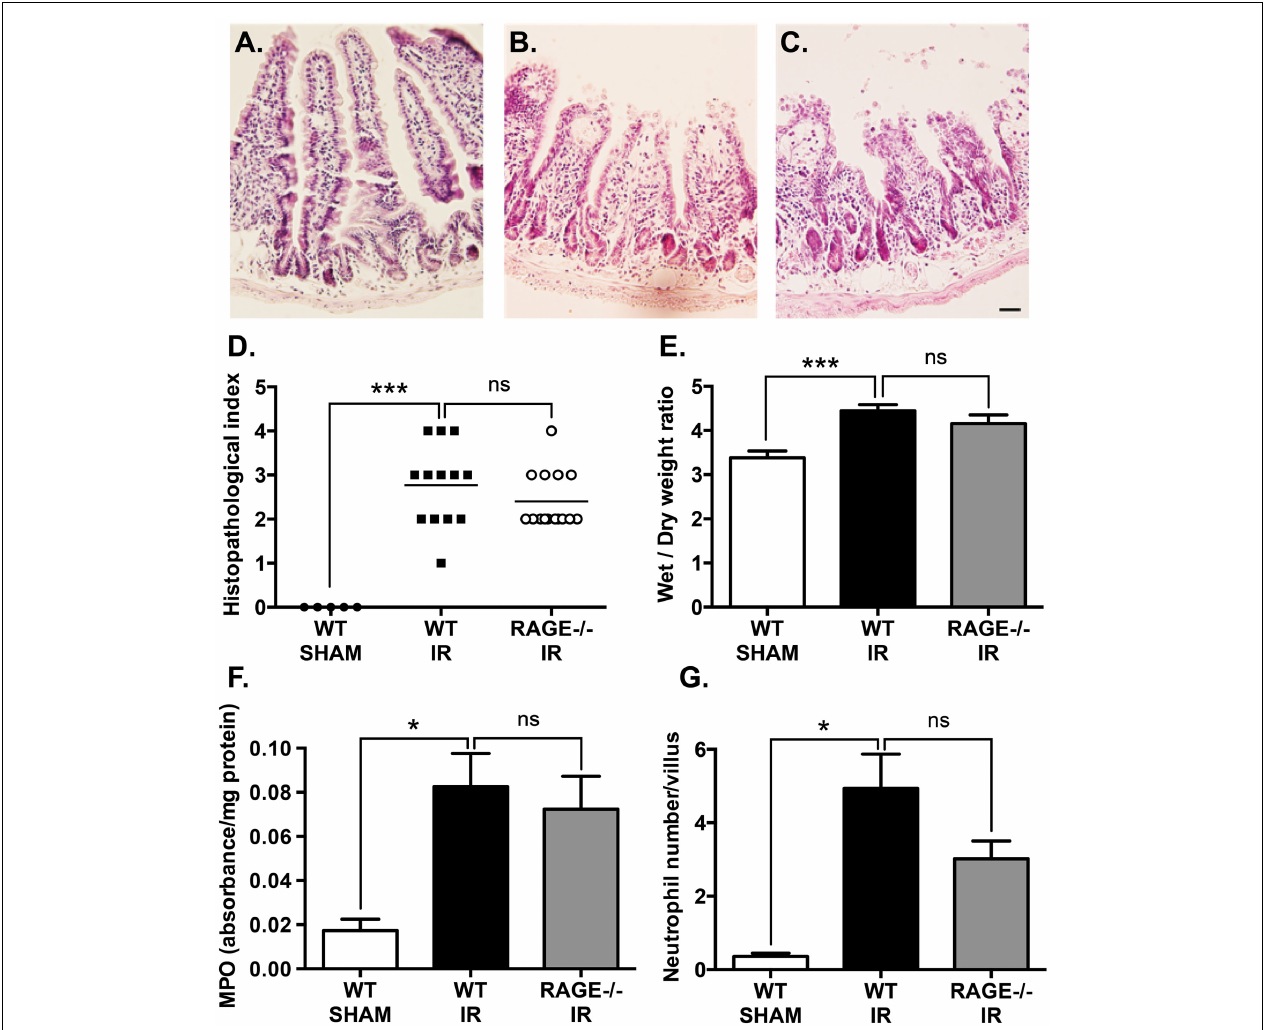
FIGURE 2 | Elimination of RAGE signaling does not impact mucosal damage and neutrophil accumulation following mesenteric IR . Mice were subjected to 30min mesenteric artery occlusion, followed by 150min reperfusion. (A–C) Representative H&E staining of cross-sections of ileum from (A) sham-operated wild-type mice (WT-SHAM), (B) mesenteric IR wild-type mice (WT-IR), and (C) mesenteric IR RAGE (cid:0) / (cid:0) mice (RAGE (cid:0) / (cid:0) IR) groups. Scale bar = 50 μ m. The mucosal injury was semi-quantitated as expressed as histopathological index (D) demonstrating no significant effect on IR injury following RAGE elimination. Increases in intestinal edema, as measured by wet/dry weight ratios (E) , were also not impacted by RAGE signaling elimination. Similar results were seen following quantification of myeolperoxidase levels in intestinal homogensates, normalized by total protein levels (F) , and esterase stained (Leder’s) neutrophil counts in the entire cross-section of intestine and normalized to number of villi (G) . Data are presented as mean (cid:6) SEM, n = 5 (WT-SHAM); n = 13 (WT-IR); n = 15 (RAGE (cid:0) / (cid:0) IR) where * p < 0.05, *** p < 0.001, and ns = not-significant ( p >